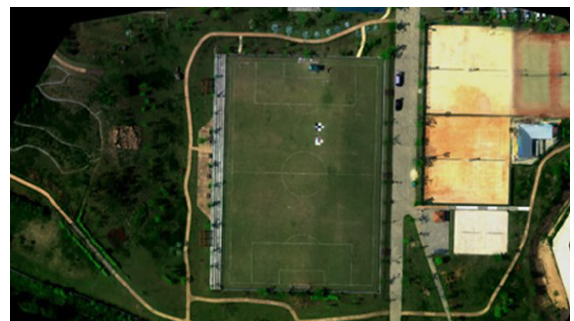
Figure 4. A natural color composite of reflectance map generated for validation